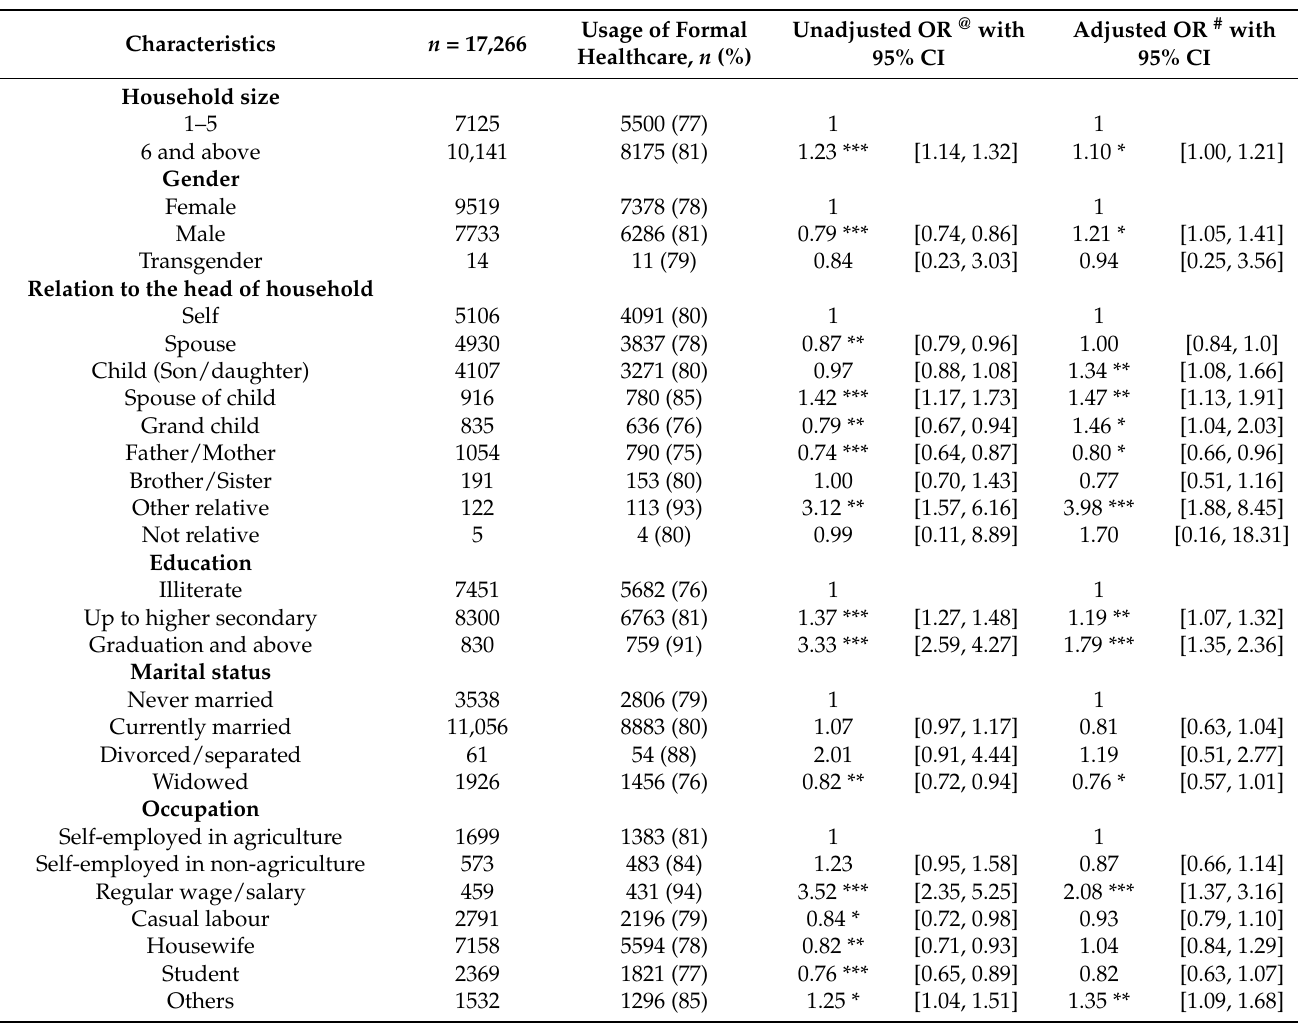
Table 3. Socio-demographic factors associated with usage of formal healthcare among people living in the GHDSS cohort ( n =